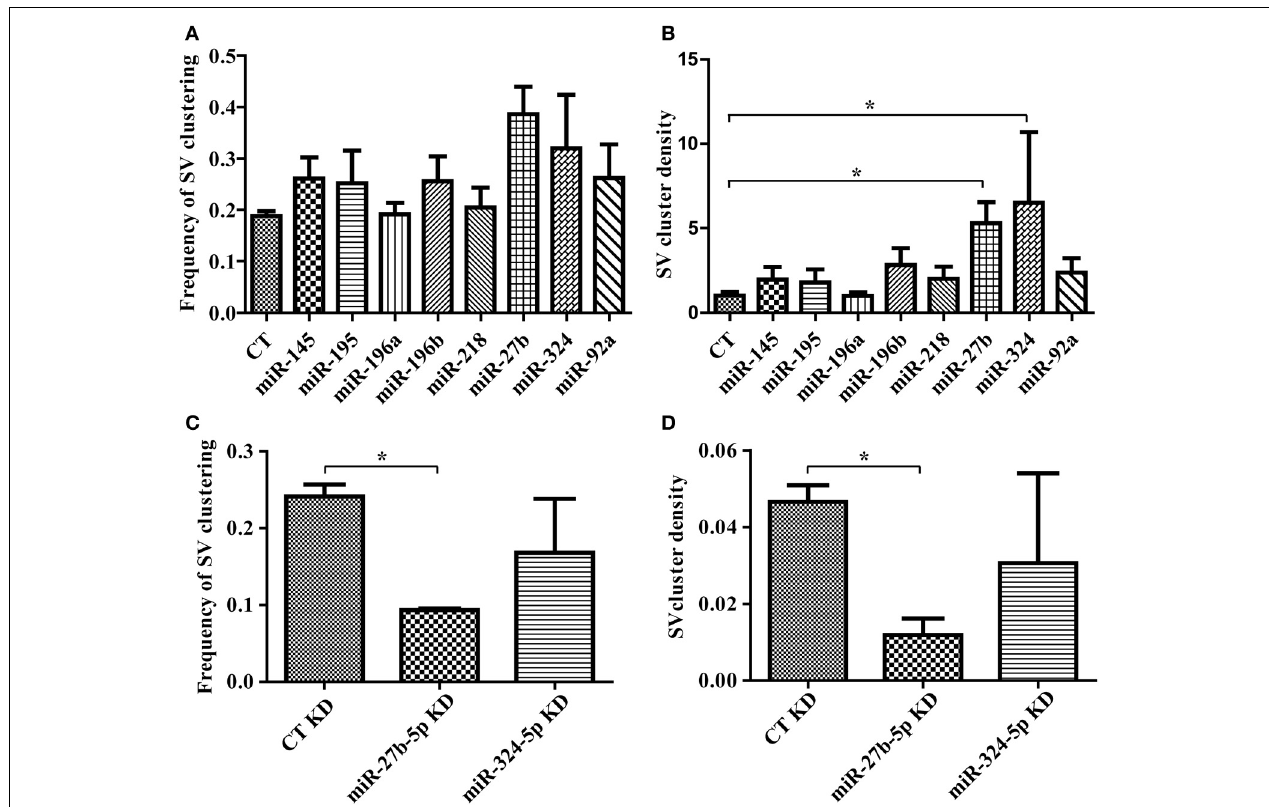
FIGURE 4 | Software-based detection of synaptic vesicle (SV) clusters reveals specific effects of miRNAs on presynaptic assembly. (A,B) Hippocampal neurons were transduced with viruses expressing the empty vector (CT) or miRNAs, cultured with HEK293T cells transfected with mCherry alone or mCherry with LRRTM2 and immunostained against synaptobrevin. n = 3–6 independent experiments for each condition and six fields (20 × ) were imaged. (A) Frequency of SV clusters in the presence of